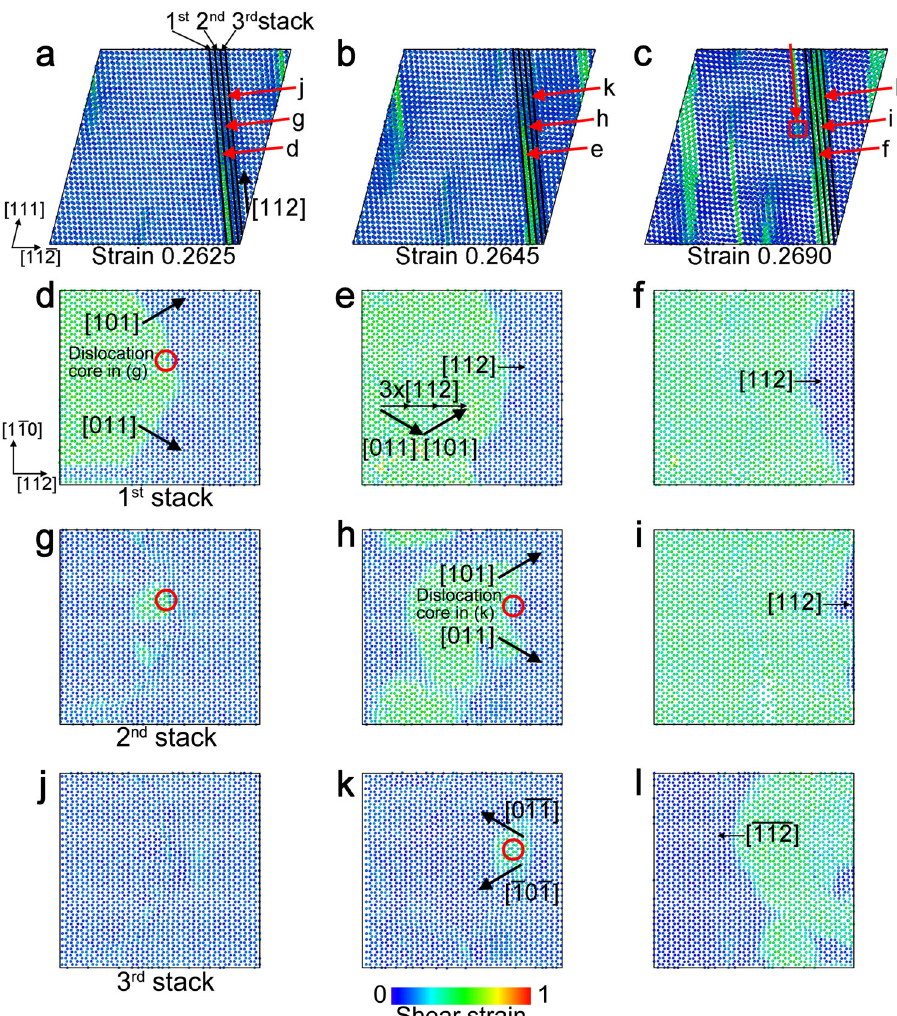
Fig. 2 Structural deformation during stress dropping stage. a Deformation of whole structure at 0.2625 shear strain. d , g , j The cross- sections of the fi rst, second, and third stack in a . b Deformation of whole structure at 0.2645 shear strain. e , h , k The cross-sections of the fi rst, second, and third stack in b . c Deformation of whole structure at 0.2690 shear strain. f , i , l The sections of the fi rst, second, and third stack in c . Atoms are colored coded by the atomic shear strain. The path of two perfect dislocations reacting into three partial dislocations is embedded in e . The part in red rectangle in c is the area of Fig.